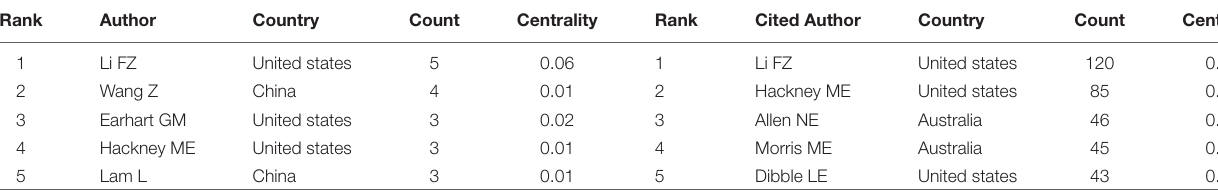
TABLE 4 | The top 5 prolific authors and cited authors.